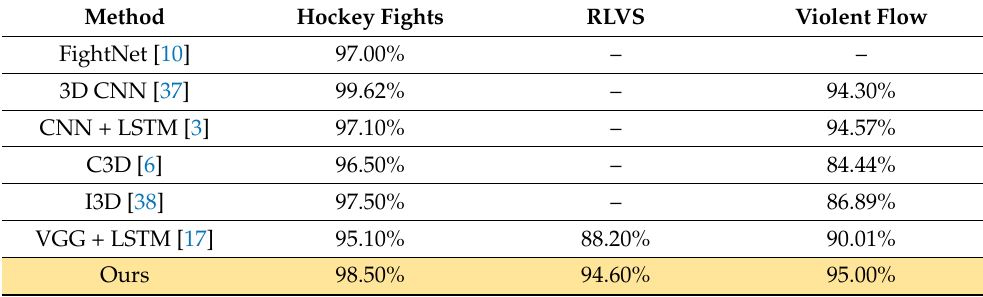
Table 9. Comparisons between the proposed method and others on previous